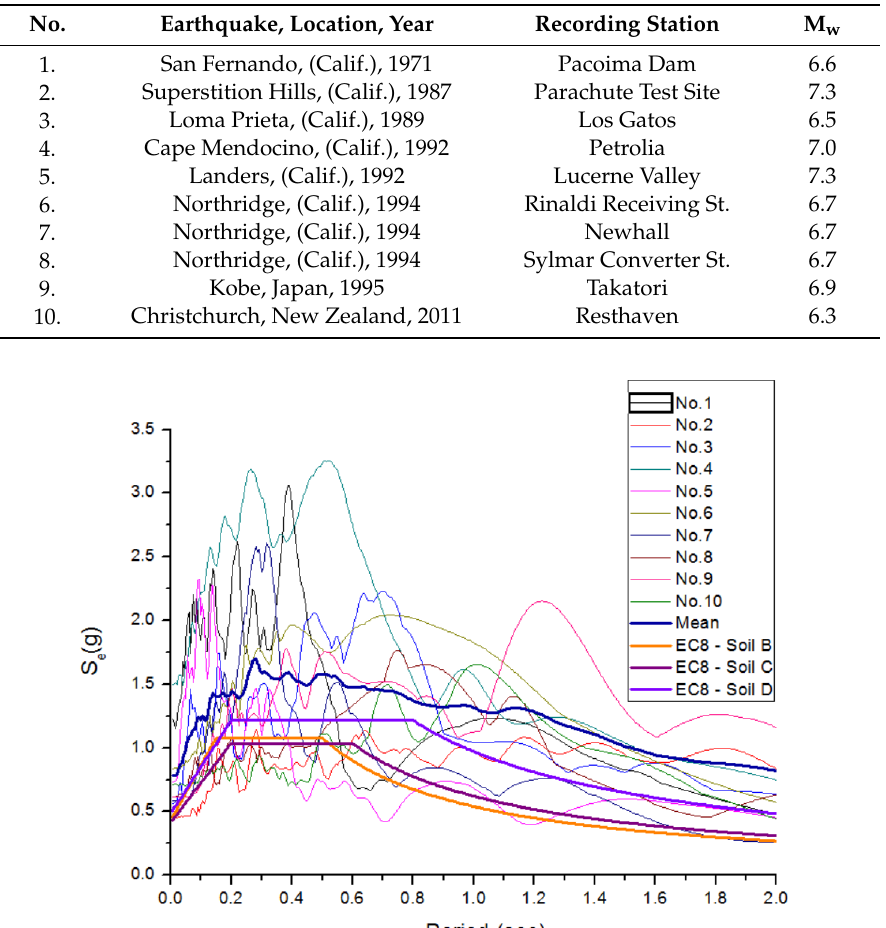
Table 4. Near-fault accelerograms considered.